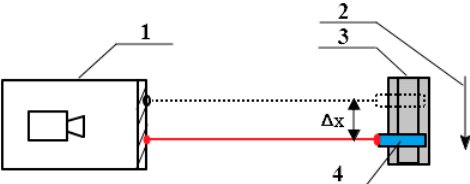
Figure 16. Conversion coefficient calibration experiment. 1. image acquisition module; 2. movement direction; 3. micro motion platform; 4. laser.